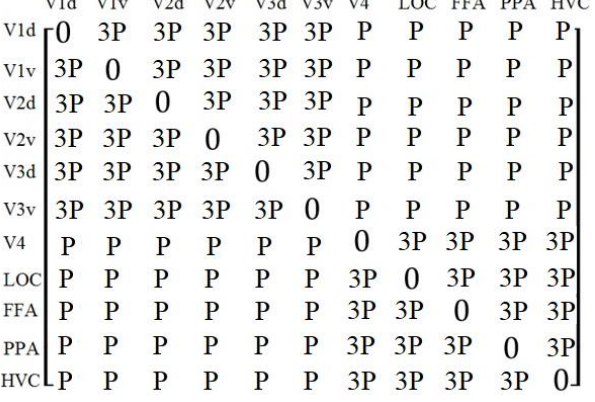
Figure 5. The adjacency matrix in the proposed algorithm, where P indicated the Pearson correlation coefficient between ROIs.